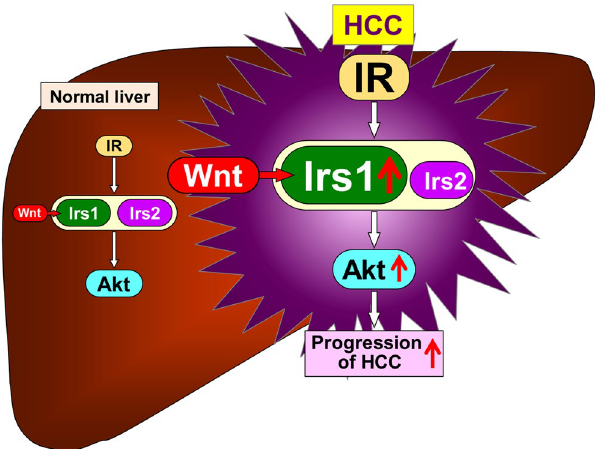
Figure 7. Schematic representation of mechanisms underlying crosstalk between Wnt/ β -catenin signaling and insulin signaling via Irs1 during hepatocarcinogenesis. Wnt/ β -catenin signaling is activated during hepatocarcinogenesis due to somatic mutations of various genes related to Wnt/ β -catenin signaling. Activated Wnt/ β -catenin signaling upregulates Irs1 gene and protein expression. Upregulated Irs1, but not Irs2, enhances insulin signaling including Akt pathway and promotes the progression of